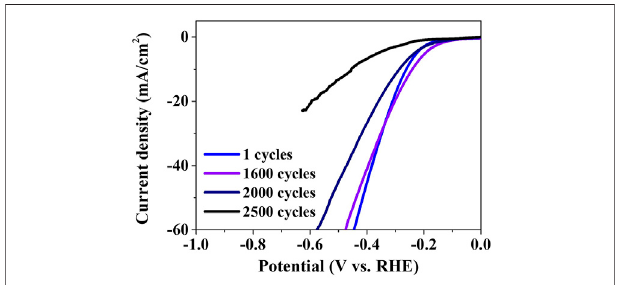
FIGURE8| ADT ofthe crystalline Ni 3 Pwith elemental Ni inclusions upto 2,500 cycle.